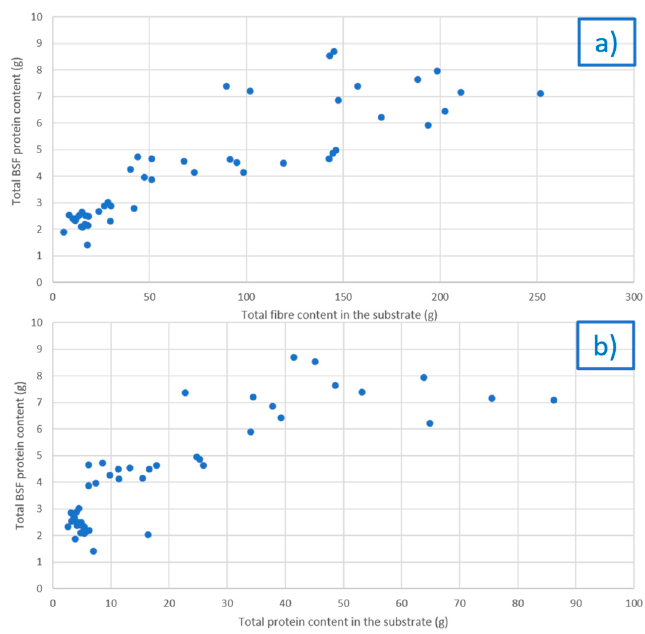
Figure 2. Correlation between total protein content (absolute amount) in the BSF prepupae biomass recorded in each experiment (starting from 300 BSF larvae) and ( a ) total fibre and ( b ) total protein contained in the rearing substrate (absolute amount).